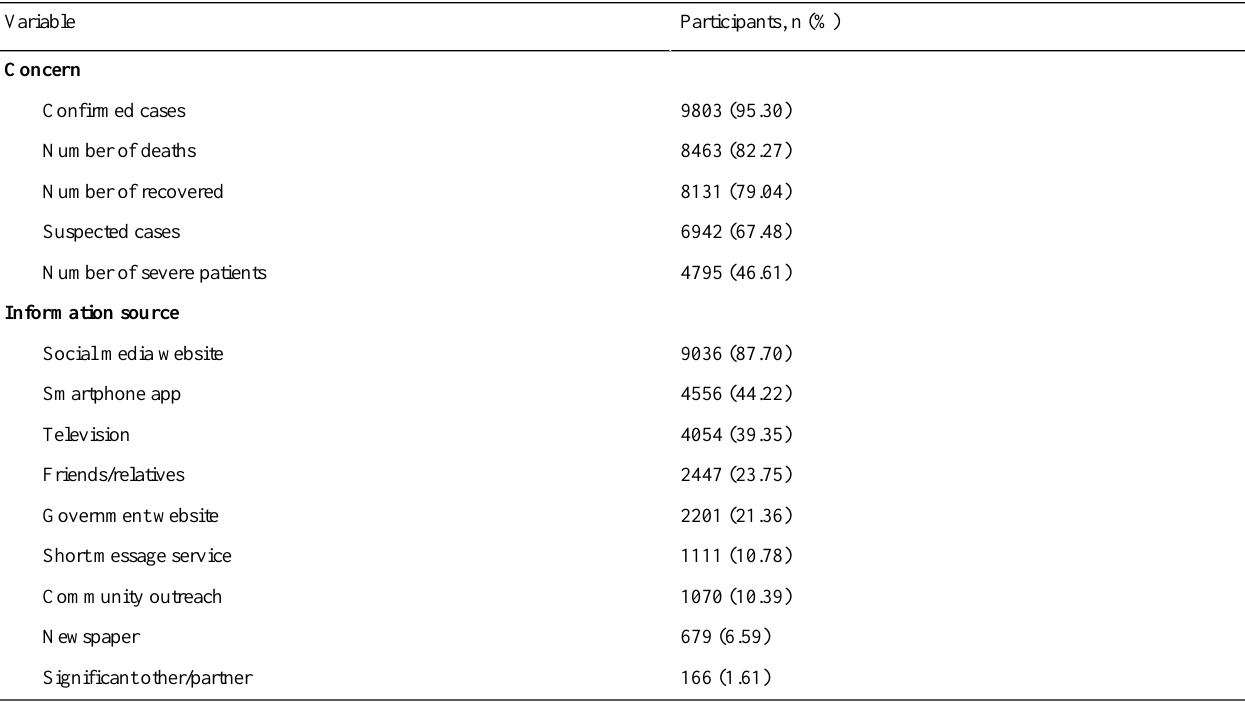
Table 2. Participants’concerns and information sources related to